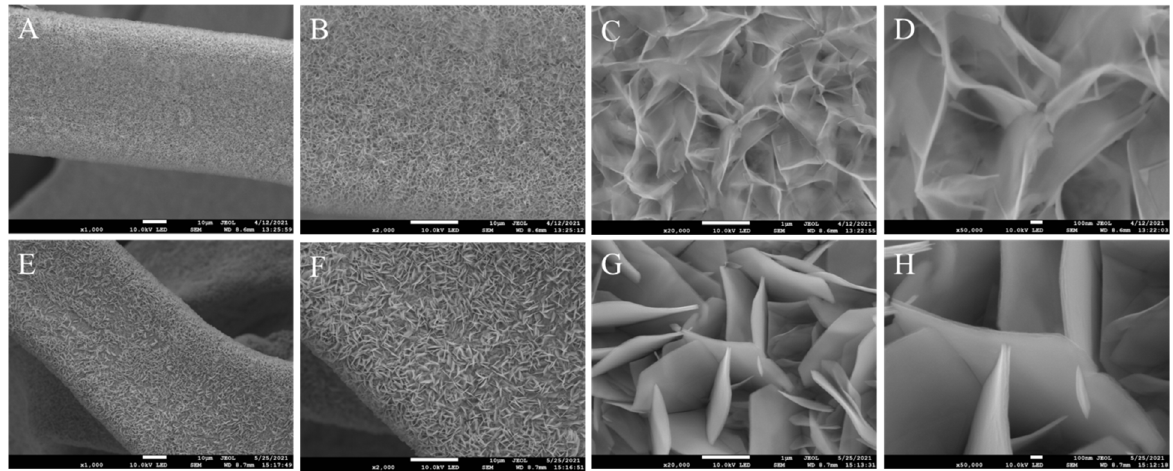
Figure 1. Low- to high-magnified SEM images of Ni(OH) 2 /NiF-40 ( A – D ) and NiO/NiF ( E – H ), which showing the porous layered nanosheets network structures. Scale Bars: 10 μ m ( A , B , E , F ); 1.0 μ m ( C , G ), and 100 nm ( D , H ).